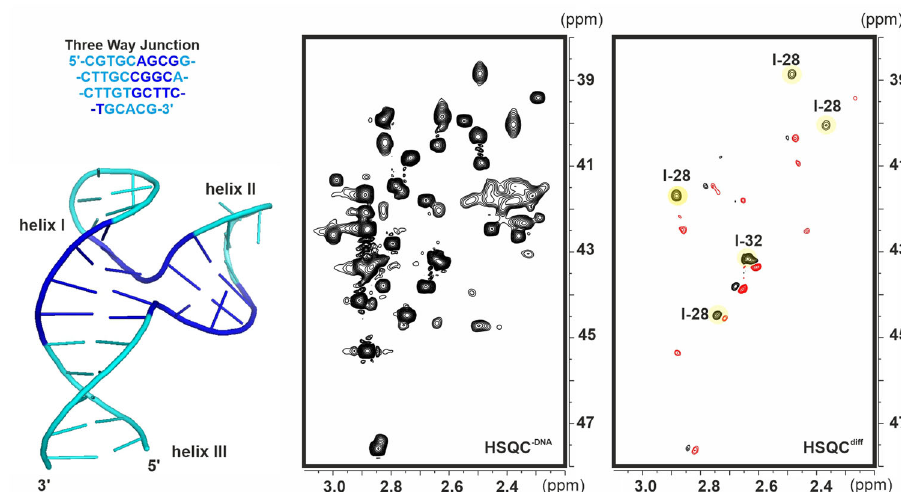
Fig. 8 Protection assays with a Three-way junction DNA. Structure of the model three-way junction (TWJ) employed in our assays together with the protection experiments performed employing the complete 53-compounds library. HSQC − DNA , and HSQC diff (imperfect subtraction due to minor pH differences between samples confers an antiphase look to some signals) data sets are represented on the middle and right panels respectively (pH